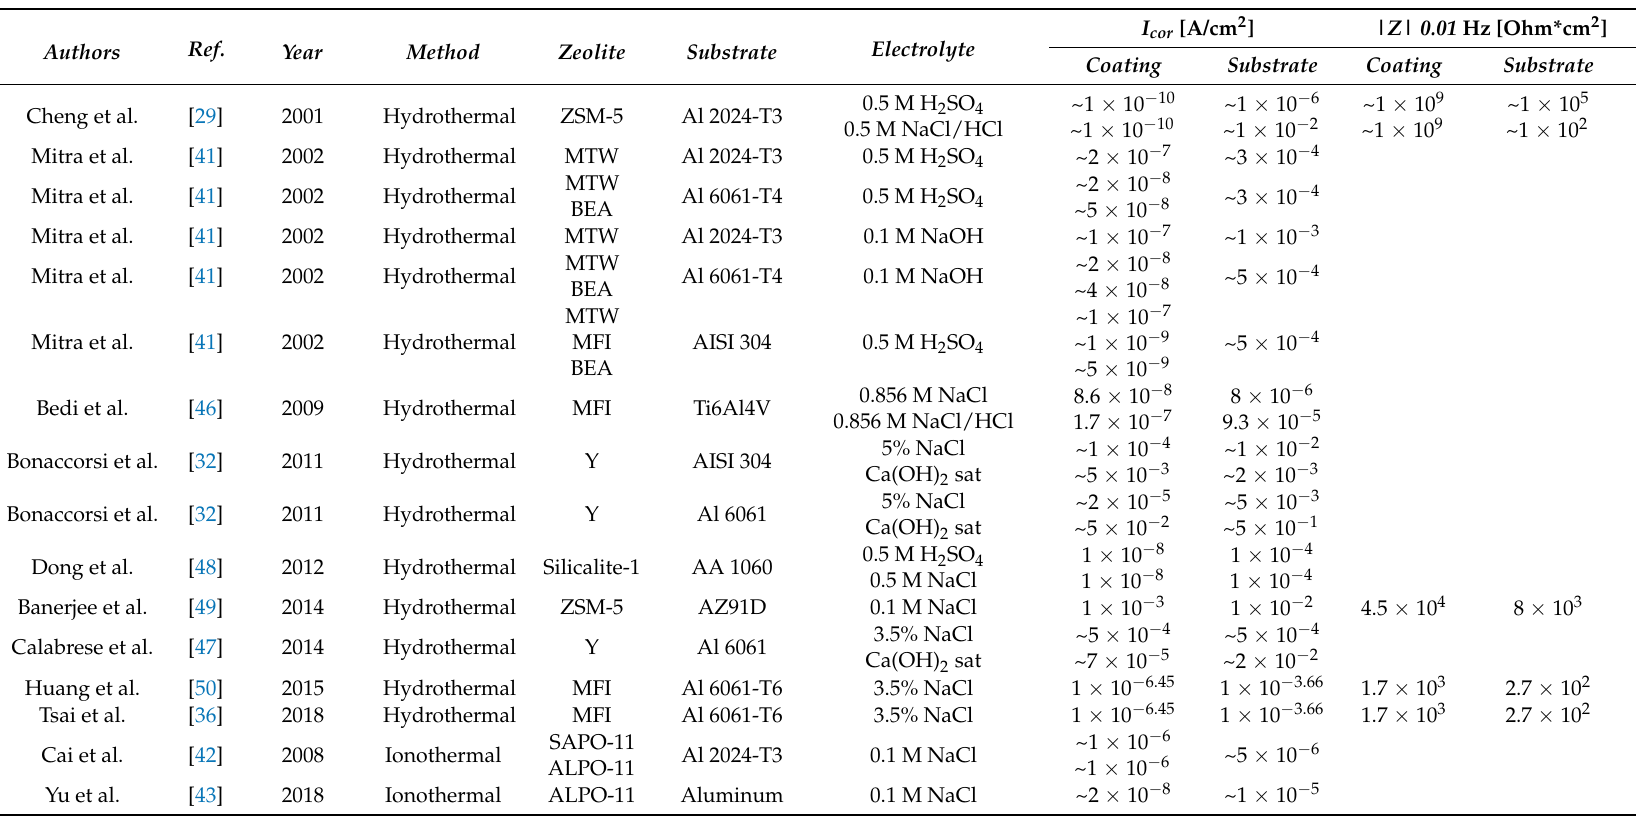
Table 1. Brief summary of the literature review of anti-corrosion performances of zeolite-based coatings obtained by the in situ crystallization technique.